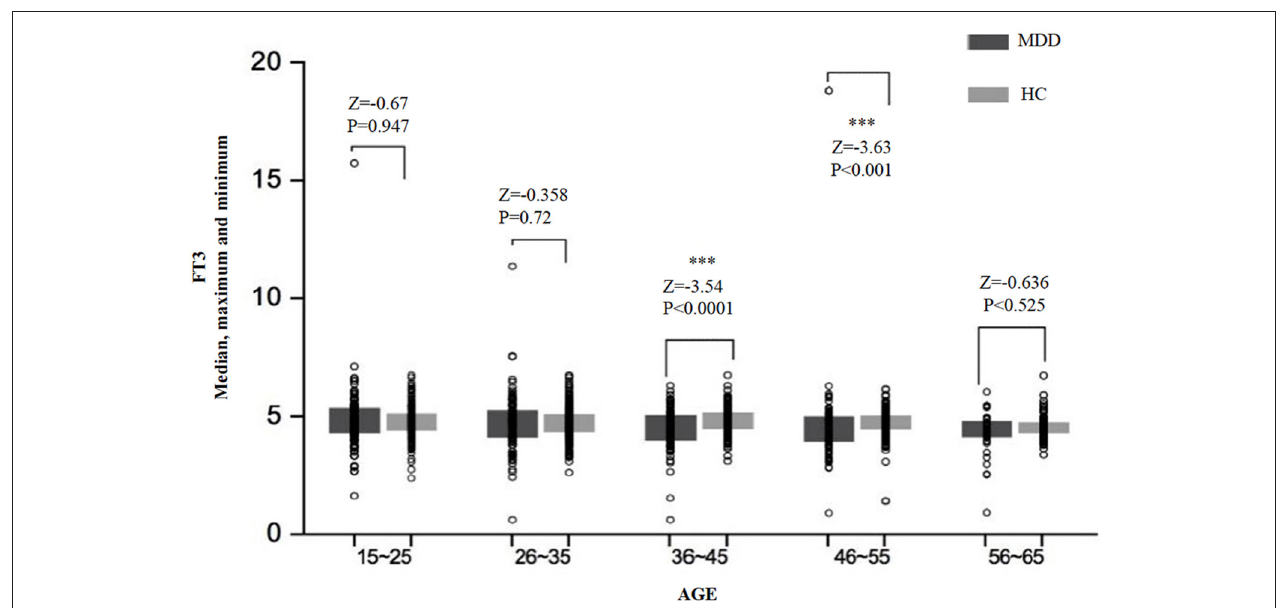
FIGURE 2 | The median, maximum, and minimum values of the FT3 level ( pmol/L ) at different ages in the MDD and HC groups. *** < 0.001.